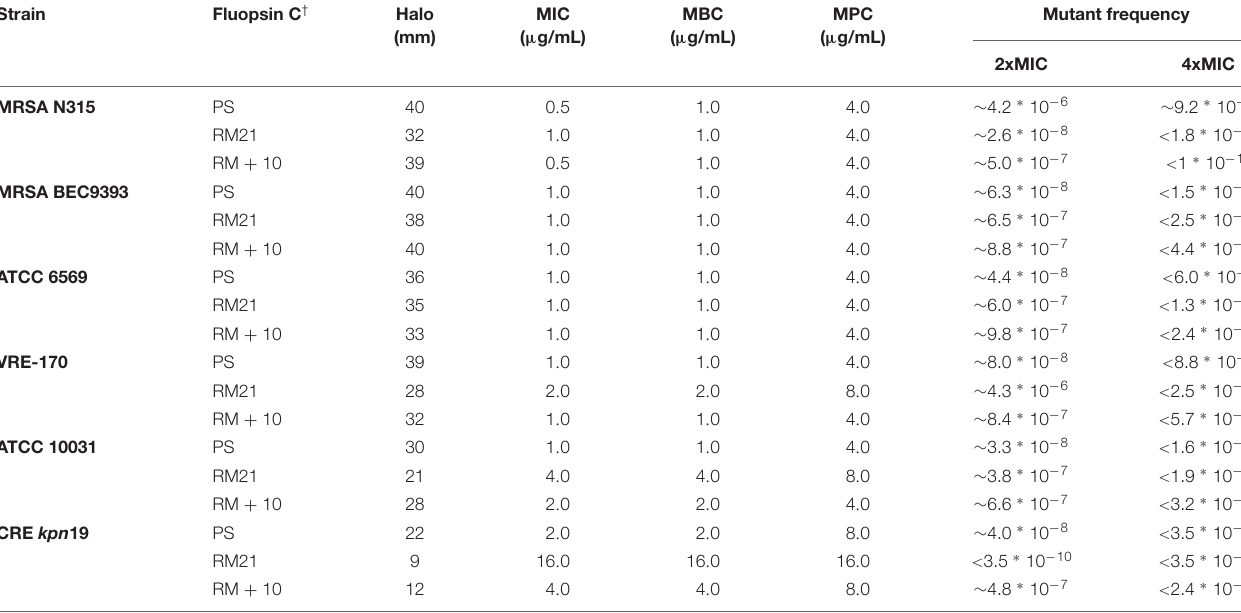
TABLE 1 | The Fluopsin C susceptibility tests: disk diffusion on agar (10 µ g/disc), MIC, MBC, MPC and mutant frequencies for parent strain and RMs. Strain Fluopsin C †